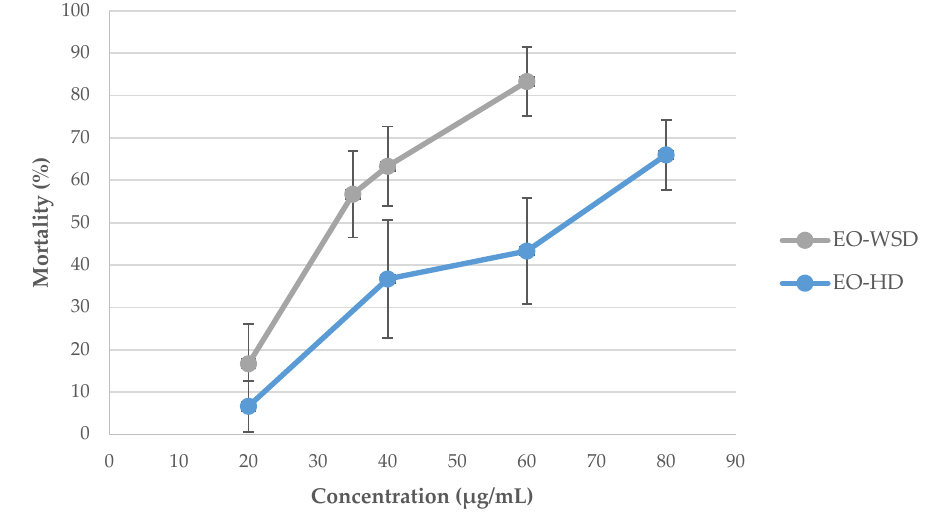
Figure 2. Radix peregra adult mortality rate (%) at different concentrations of Azorean Cryptomeria japonica leaf essential oils (OEs) obtained by two distillation techniques, after 24 h of exposure followed by a 24-h recovery period. Legend: HD, hydrodistillation; WSD, water-steam distillation.